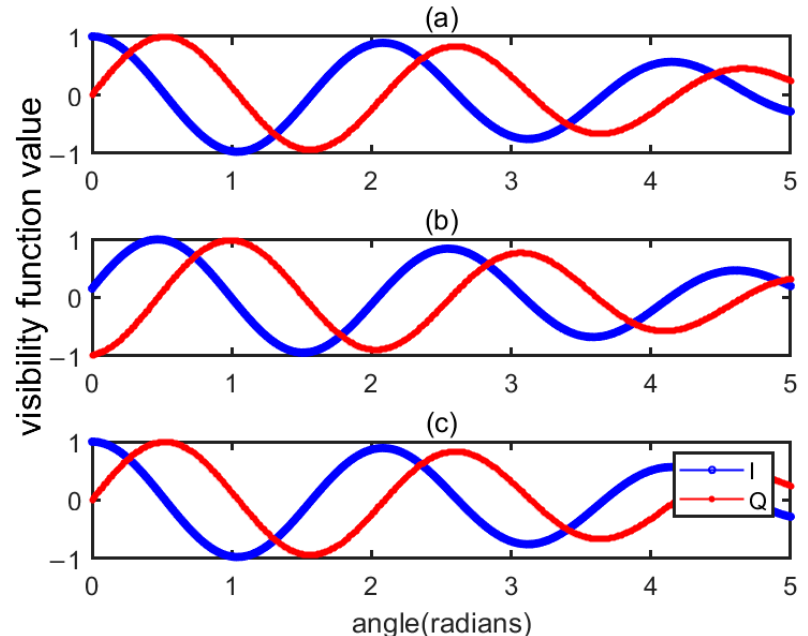
Figure 5. Comparison of visibility function before and after compensating error. ( a ) is the visibility function without the phase error, ( b ) is the visibility function assuming a 30-degree phase error, and ( c ) is the visibility function after compensating for the phase error.